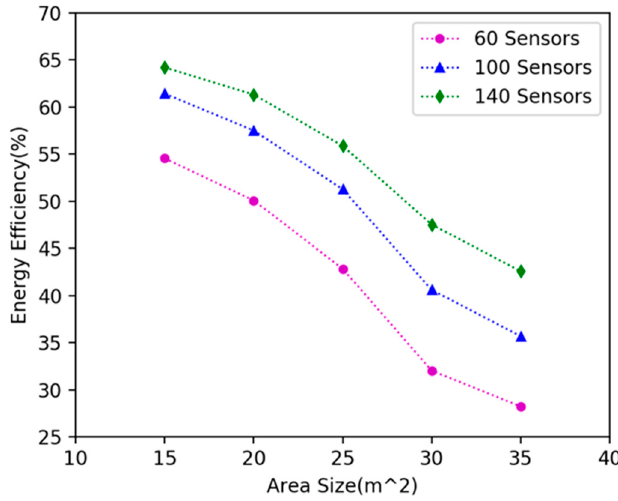
Figure 13. The influence of area size on energy efficiency of the DCV.